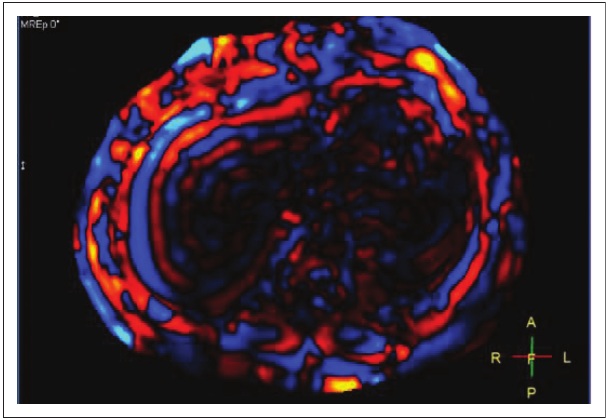
FIG URE 7: Good quality elastogram with regular waves formed parallel to the liver